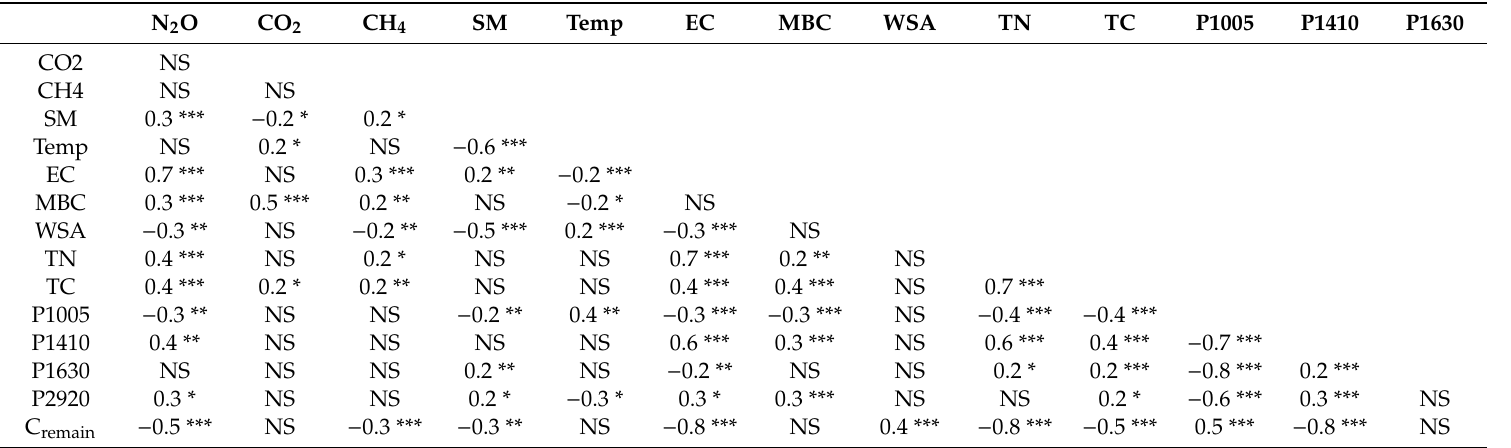
Table 6. Correlation matrix between di ff erent parameters for all data (CO 2 : carbon dioxide emissions; N 2 O: nitrous oxide emissions; CH 4 : methane emissions; SM: soil moisture; Temp.: soil temperature; EC: electrical conductivity; WSA: water-stable aggregates; MBC: microbial biomass carbon; TN: total nitrogen; TC: total carbon; P1005: relative absorbance of the FTIR peak for silicates and clay minerals as well as C–O–C stretching in polysaccharides; P1410: relative absorbance of the FTIR peak for C–O bond vibrations and also the vibrations in C–N (amide III); P1630: relative absorbance of the FTIR peak for the aromatic C = C and C = O vibrations of amide I groups; P2920: relative absorbance of the FTIR peak for asymmetric C–H vibration of aliphatic compounds; C remain : observed remaining carbon from crop residues in the soil after 105